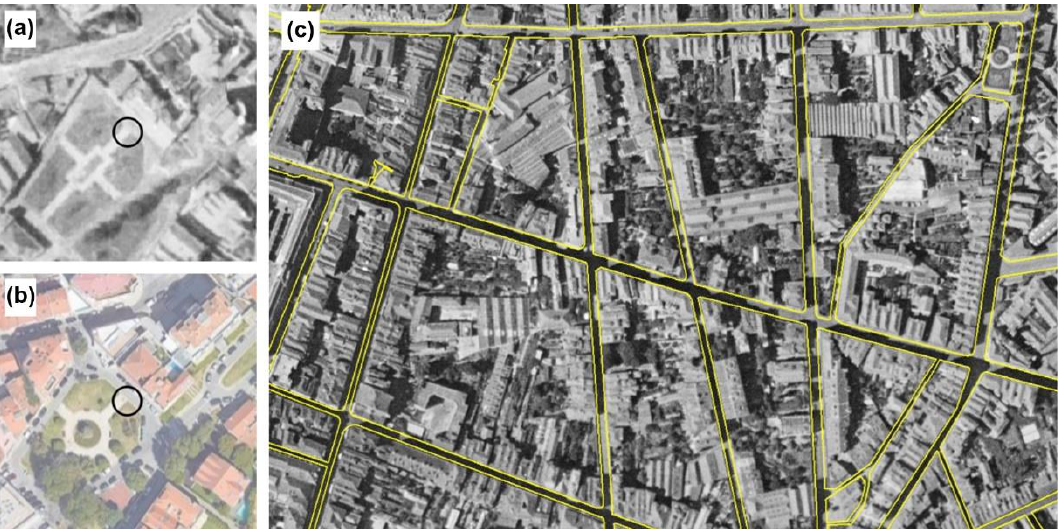
Figure 2. ( a ) Examples of a GCP in the 1947 aerial photo; ( b ) the same point in present time orthoimages; ( c ) large portion of the final orthomosaic, with overlaid vector data of building blocks in a GIS, showing the accurate geolocation of the orthomosaic. Table 1. Land cover categories (adapted from [39]).